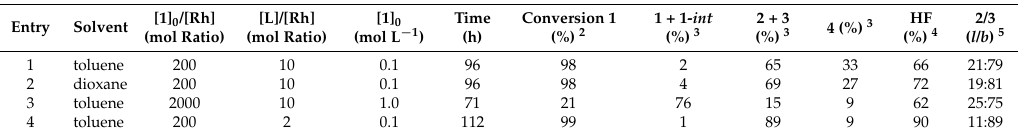
aldehydes 2 and 3 , internal alkenes 1 and 1- int , and hydrogenation product 4 (corrected from the 8% initially present), as determined by 1 H NMR analyses. 4 Chemoselectivity as determined by the percentage of